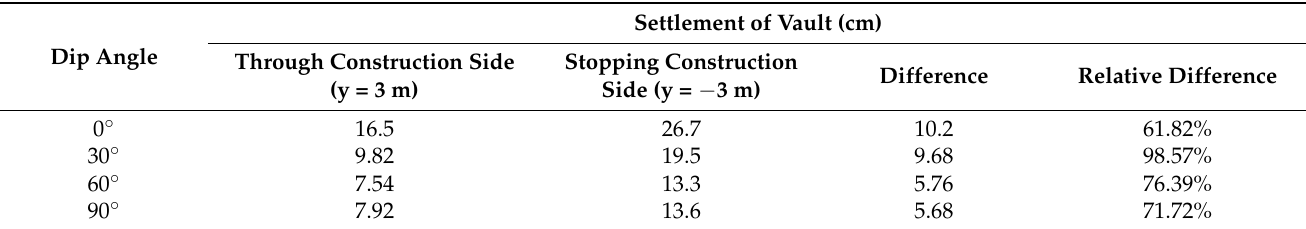
Table 4. Cumulative vault settlement from the cross-section of the tunnel under the influence of different inclination angles.